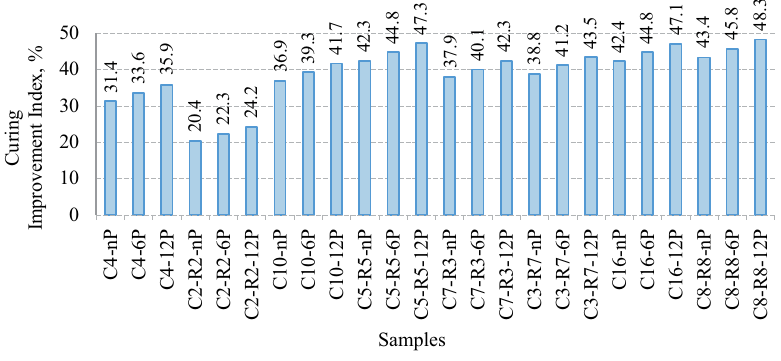
Figure 2. Curing Improvement Index of stabilised and reinforced sand-clay